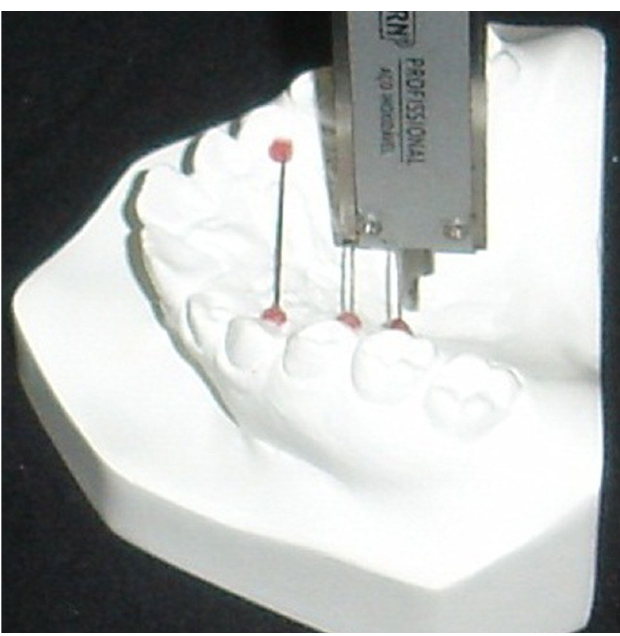
Fig. 7. Second premolar depth